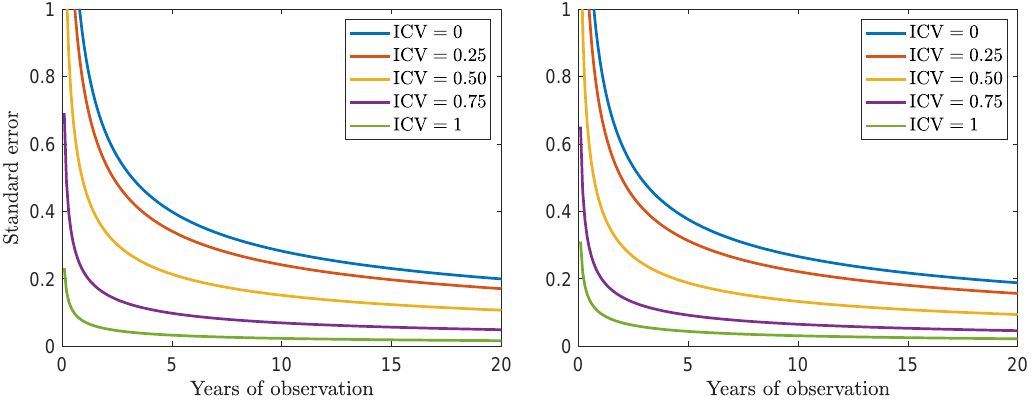
Figure 4: Standard error of Π n depending on the ICV. On the left-hand side, the holding period Π n depending on the ICV. On the left-hand side, the holding period T is Figure 4. Standard error of T is considered fixed and is equal to 5 years, whereas on the right-hand side, T is considered fixed and is equal to 5 years, whereas on the right-hand side, T is supposed to be uniformly b supposed to be uniformly distributed between 0 and 10 years. (cid:98) distributed between 0 and 10